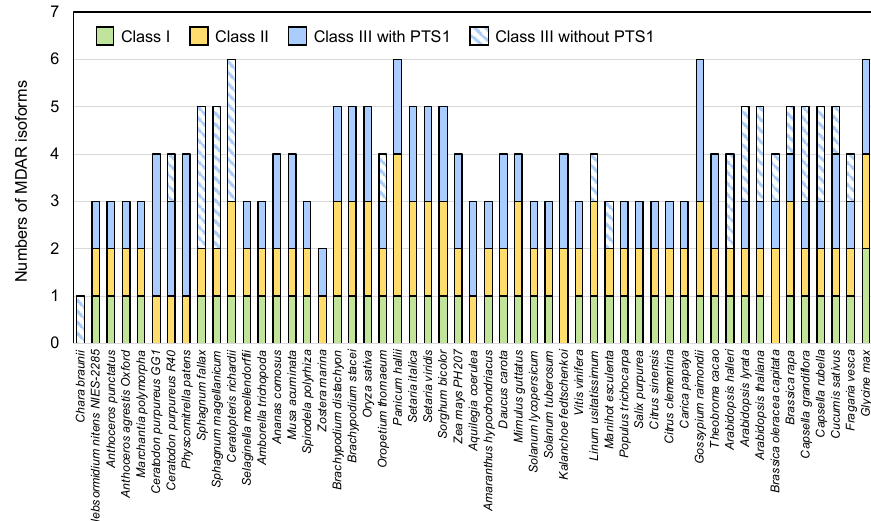
Figure 1. Numbers of MDAR isoforms in charophytes and in land plants. Numbers of MDAR isoforms in land plants and charophytes ( Klebsormidium flaccidum NIES-2285 and Chara braunii ) are shown. Classes I, II, and III are chloroplas- tic/mitochondrial, peroxisomal membrane-bound, and cytosolic/peroxisomal isoforms (see Figure 2). Class III enzymes without PTS1 are cytosol-specific isoforms. Unicellular green algae have one or two MDARs (not shown in this figure, see Table S2).